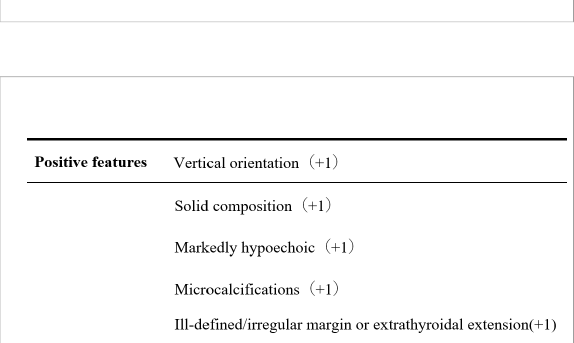
FIGURE 1 C-TIRADS based on counting method.